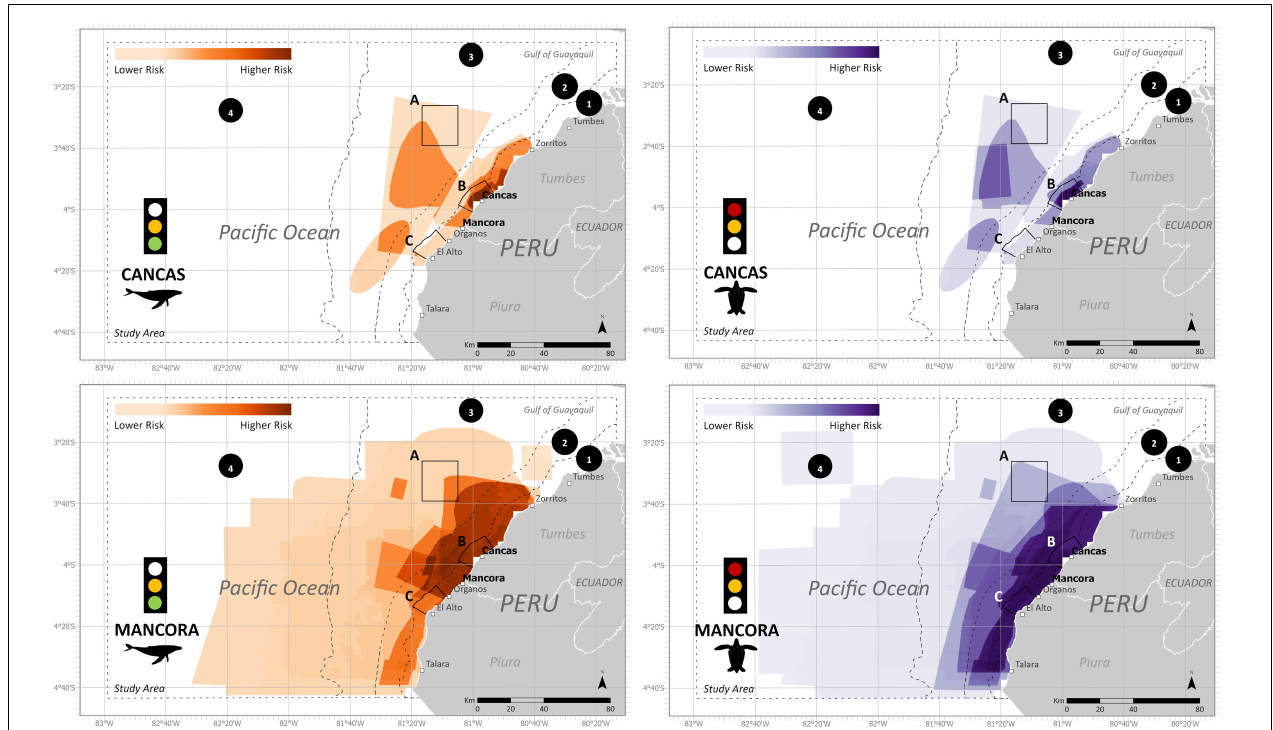
FIGURE 3 | Final estimated bycatch risk split by ports (Mancora and Cancas) for humpback whales and leatherback turtles during the austral winter (June- November) and austral summer (December-May), respectively. Subzones include (1) Artisanal fishing zone (5 nm), (2) Territorial seas zone (12 nm), (3) Shelf zone, (4) Beyond shelf zone, (A) Banco de Mancora, (B) Arrecifes de Punta Sal, and (C) Cabo Blanco–El Ñuro. Data uncertainty depicted in stoplight and described further in Table 3